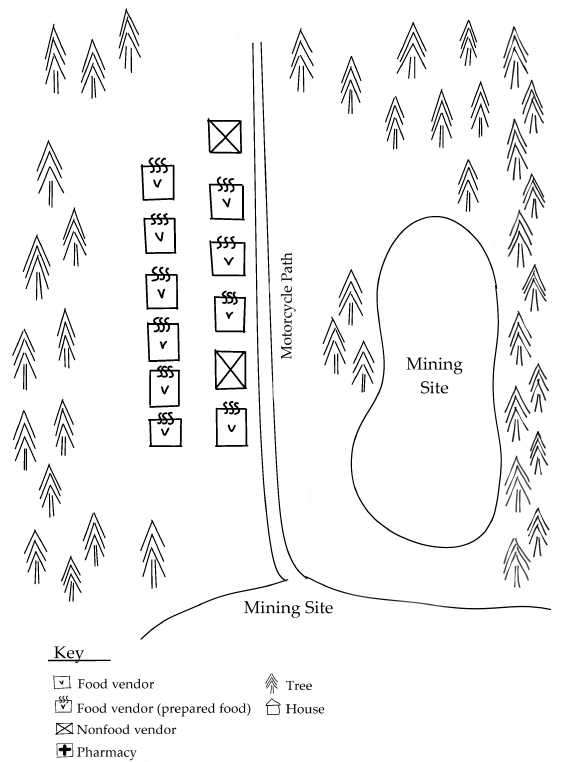
Figure 3. Map of mining site market. Most vendors sell prepared foods. Large stalls include seating areas for customers.